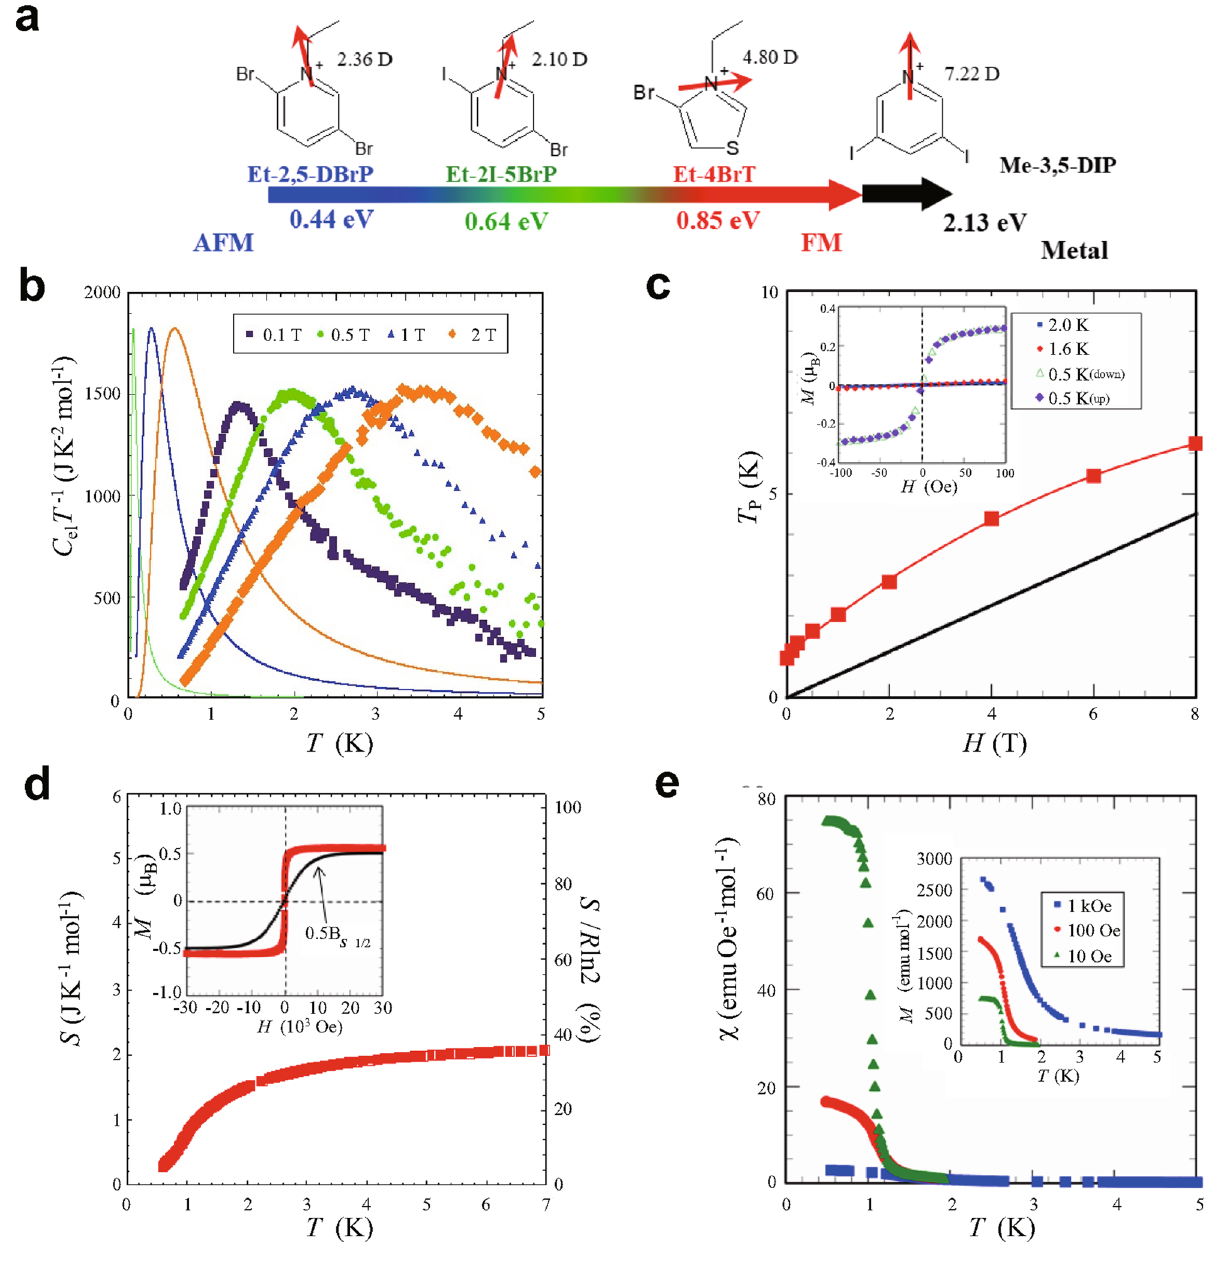
Figure 3. Molecular structures of counter cations of the series of bi-layer compounds and magnetic and thermal properties of (Et-4BrT)[Ni(dmit) 2 ] 2. ( a ) The schematic view of the molecular structure of polarized cations. The red arrows indicate the direction of the dipole moments, and the calculated electrostatic potential values in the layer A produced by the aligned cations are given in the figure. ( b ) The electronic heat capacity under magnetic field of 0.1 T, 0.5 T, 1.0 T and 2. 0 T (filled circles), compared with the simulated Schottky heat capacity under the same magnetic fields (0.5 T, 1.0 T, and 2.0 T) (solid lines). ( c ) Magnetic-field dependence of the heat capacity peak ( T p ) compared with the paramagnetic case represented by Schottky heat capacity (black line). The inset shows the magnetization curves between -100 Oe and 100 Oe at 0.5 K, 1.6 K, and 2.0 K. ( d ) Temperature dependence of magnetic entropy of (Et-4BrT)[Ni(dmit) 2 ] 2 derived from the magnetic heat capacity. The inset shows the magnetization curve at 0.5 K which shows ferromagnetic saturation of the magnetization. The black solid curve in the inset is the Brillouin function expected for the case of paramagnetic case. ( e ) Temperature dependence of magnetic susceptibility of (Et-4BrT)[Ni(dmit) 2 ] 2 .The inset shows the temperature dependence of magnetization. The external fields are 10 Oe, 100 Oe, and 1